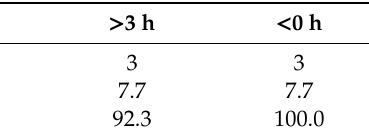
Figure 9. Statistical analysis of rainfall induced landslides in the Sondrio and Brescia Provinces in the 1927–2008 period. ( A ) spatial distribution of the processes in the two provinces: SO, Sondrio Province; BS, Brescia Province. ( B ) Classification of the processes based on the accuracy of the time of landslide occurrence (accurate time or indefinite period). ( C ) Classification of the processes based on the type of the rainfall measurements available (hourly or sub-hourly and daily) and further classification of the events for which hourly rainfall data are available based on the accuracy of the time of the landslide occurrence (accurate time or indefinite period). Table 1. Classification of the summer events based on the period (t, in h) between the time of the maximum recorded peak of rainfall intensity and the time of landslide occurrence. For each temporal break, we estimated the number of events (N), the percentage respect the total events (%), and the cumulated percentage (% cum ) that represents the percentage of landslides occurred in each temporal break added to the previous ones. ∆ t < 0 h represents the period before the maximum rainfall